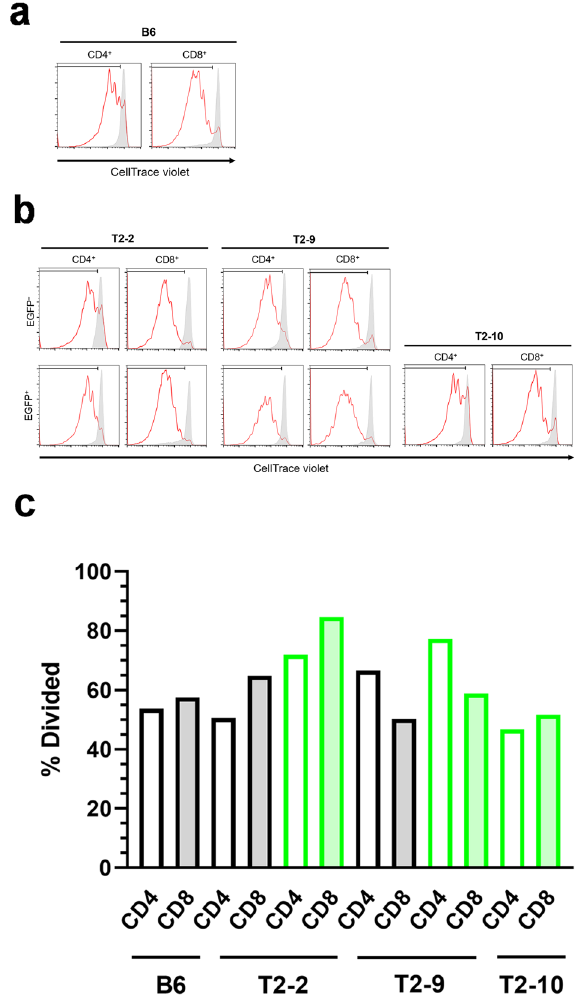
with anti-CD3/CD28 antibody beads for 3 days, and then underwent flow cytometry. ( a ) Histograms of CellTrace Violet staining in CD4 + or CD8 + T cells derived from a B6 mouse. Stimulated, red lines; unstimulated, gray shading. ( b ) Histograms of CellTrace Violet staining in EGFP − CD4 + and EGFP + CD4 + T cells and EGFP − CD8 + and EGFP + CD8 + T cells derived from B6 ESC CAG-EGFP → Foxn1 nu / nu chimeric mice (nos. T2-2, T2-9, and T2-10). Stimulated, red lines; unstimulated, gray shading. ( c ) Percentages of divided EGFP − CD4 + and EGFP + CD4 + T cells and EGFP − CD8 + and EGFP + CD8 + T cells derived from chimeric mice, as well as CD4 + and CD8 + T cells of B6 mice, as determined by using CellTrace Violet staining and FlowJo software. Black borders on bars indicate EGFP − T cells and green borders indicate EGFP + T cells. Open boxes indicate CD4 + T cells and color-shaded (gray or green) boxes indicate CD8 + T